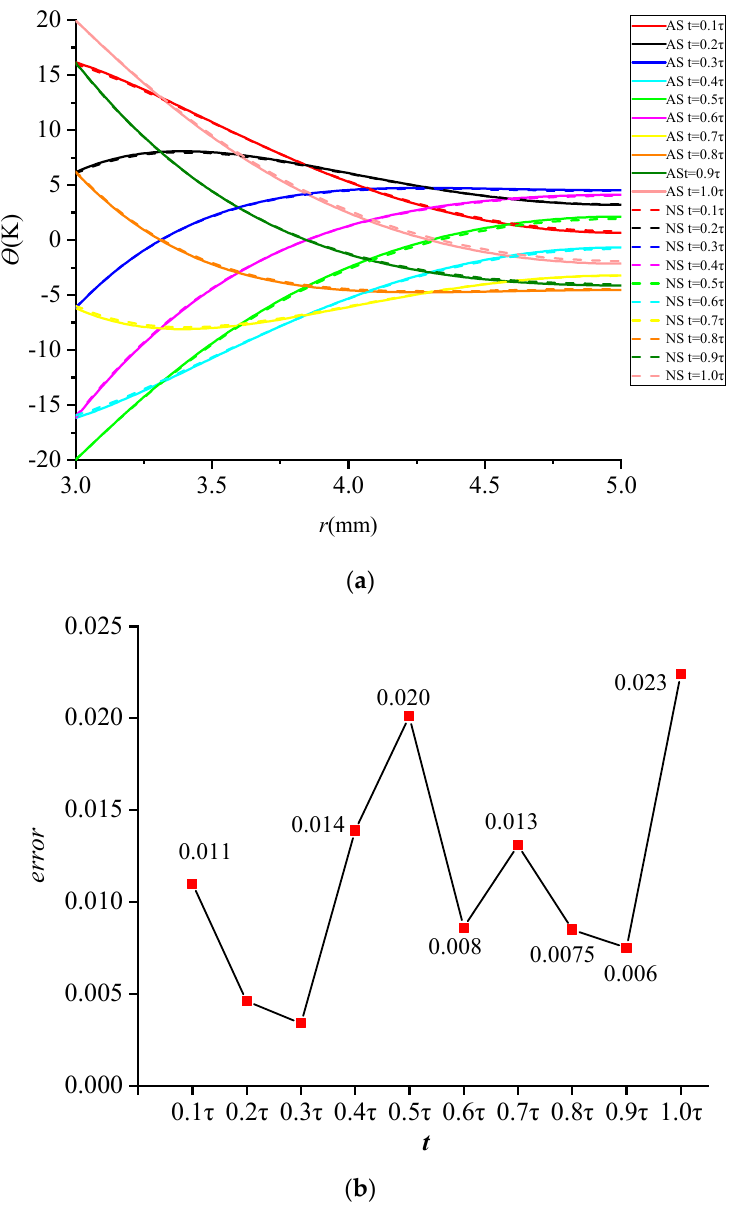
Figure 15. Comparative analysis of numerical solution and analytical solution ( a ) temperature distribution ( b ) error analysis.